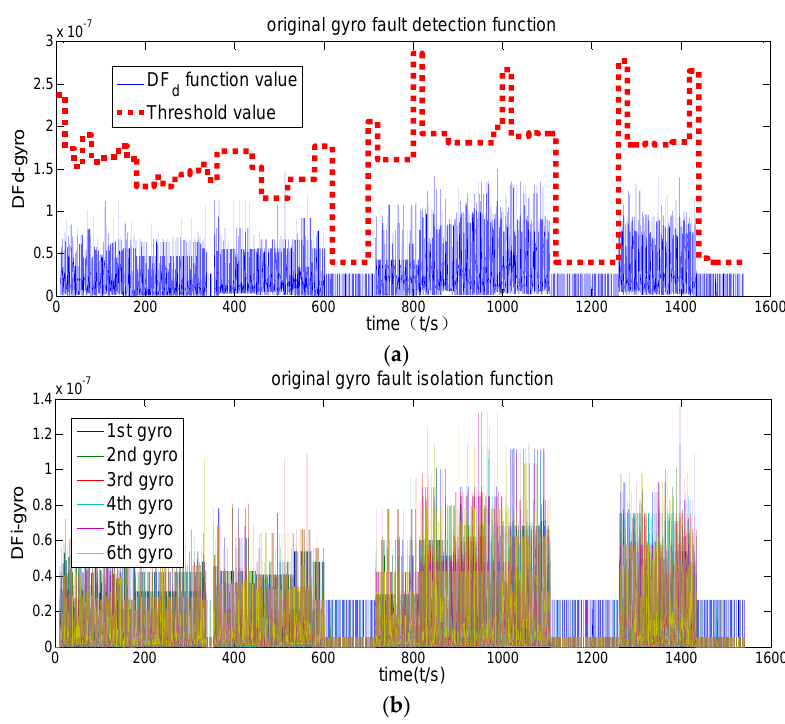
Figure 8. Original channel filter (the fault amplitude is 0.5 ◦ /h). ( a ) Fault detection; ( b ) Fault isolation.